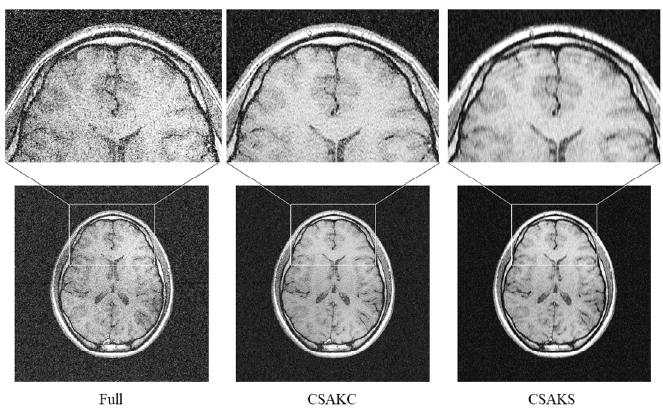
Figure 5. Visual comparison of a full k-space image and CSAK images in a human subject. Although CSAK images were acquired with the same undersampling ratio, the ringing artifacts only occurred when using CSAKS. Note that the acquisition times of the full k-space and CSAK images were 5 m 56 s and 5 m 5 s, respectively.